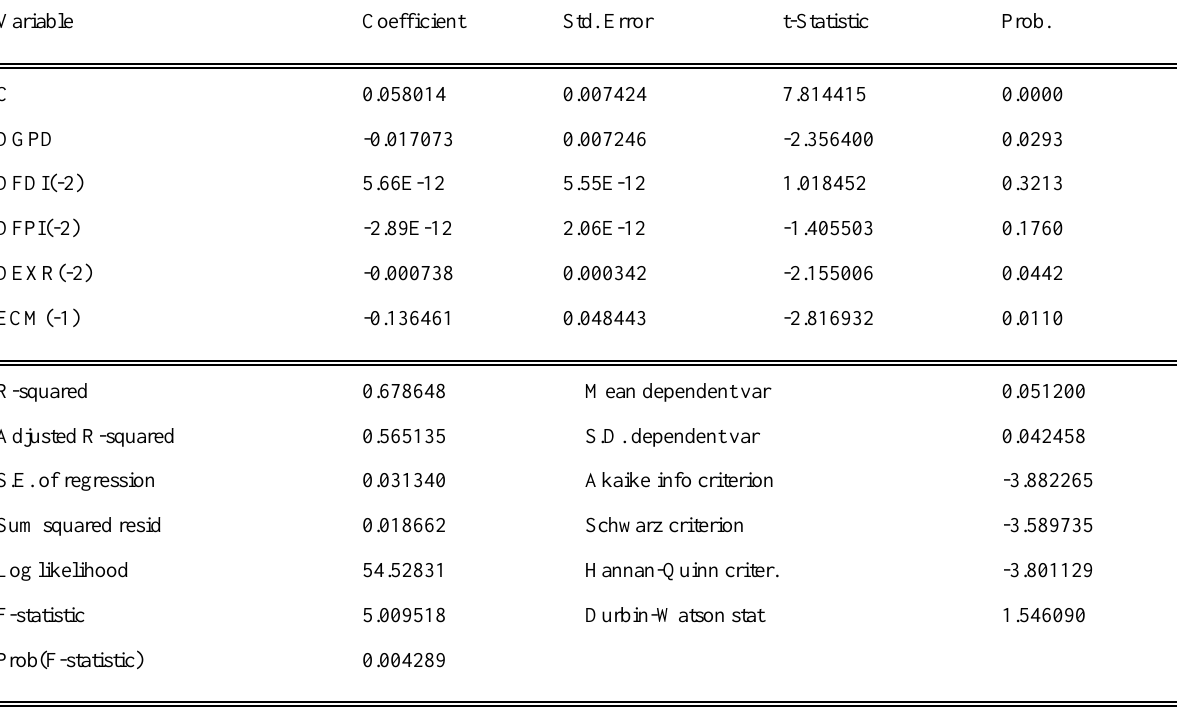
Table 8: Error Correction